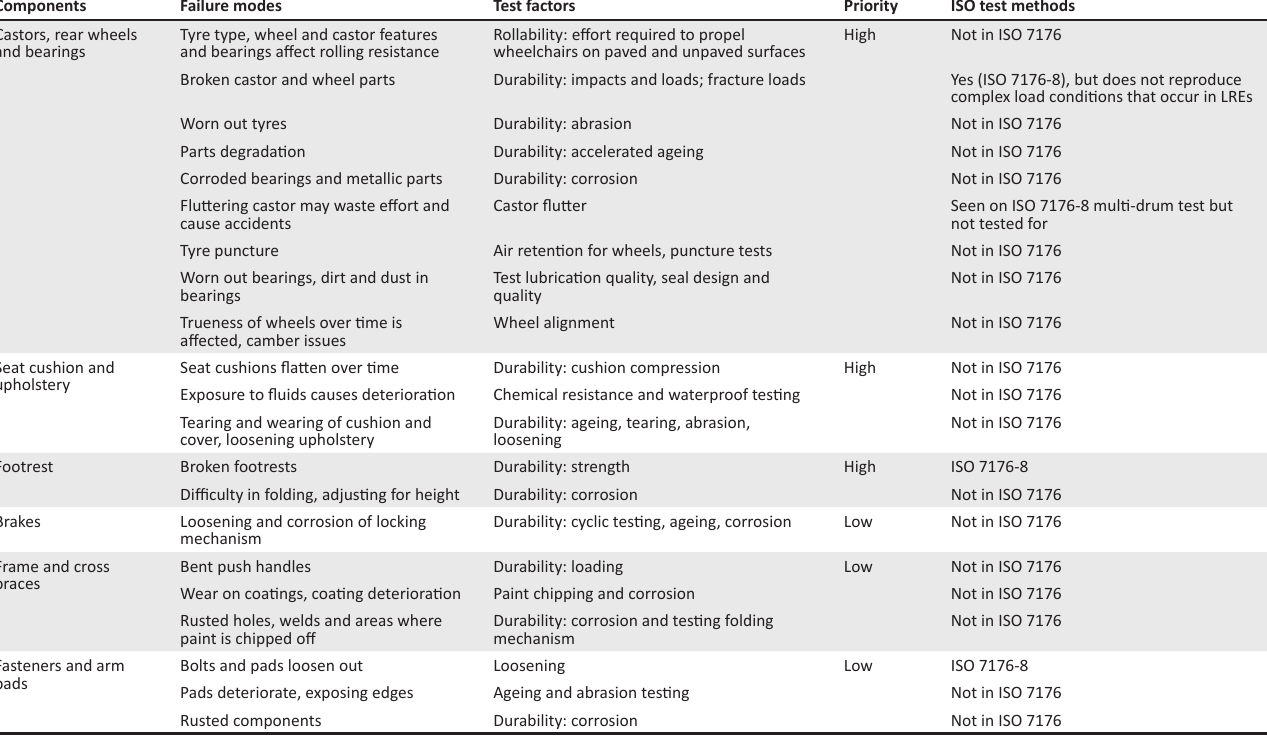
TABLE 4: Product testing matrix. Components Failure modes Castors, rear wheels and